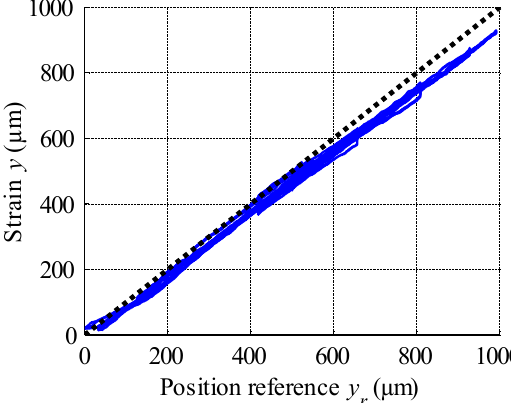
Figure 17. Open-loop control with compensator placed in series in the control loop.